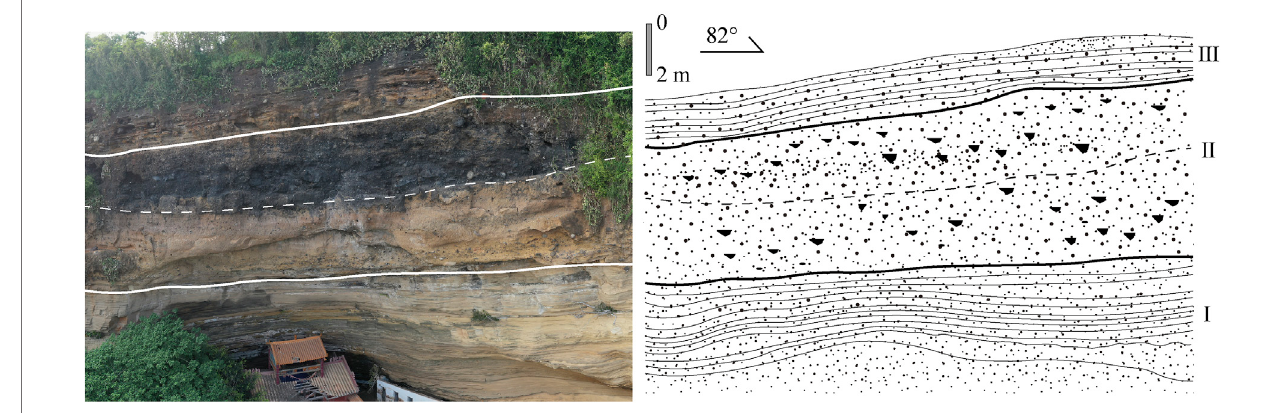
FIGURE 7 | Stratigraphic log at Tianhougong.